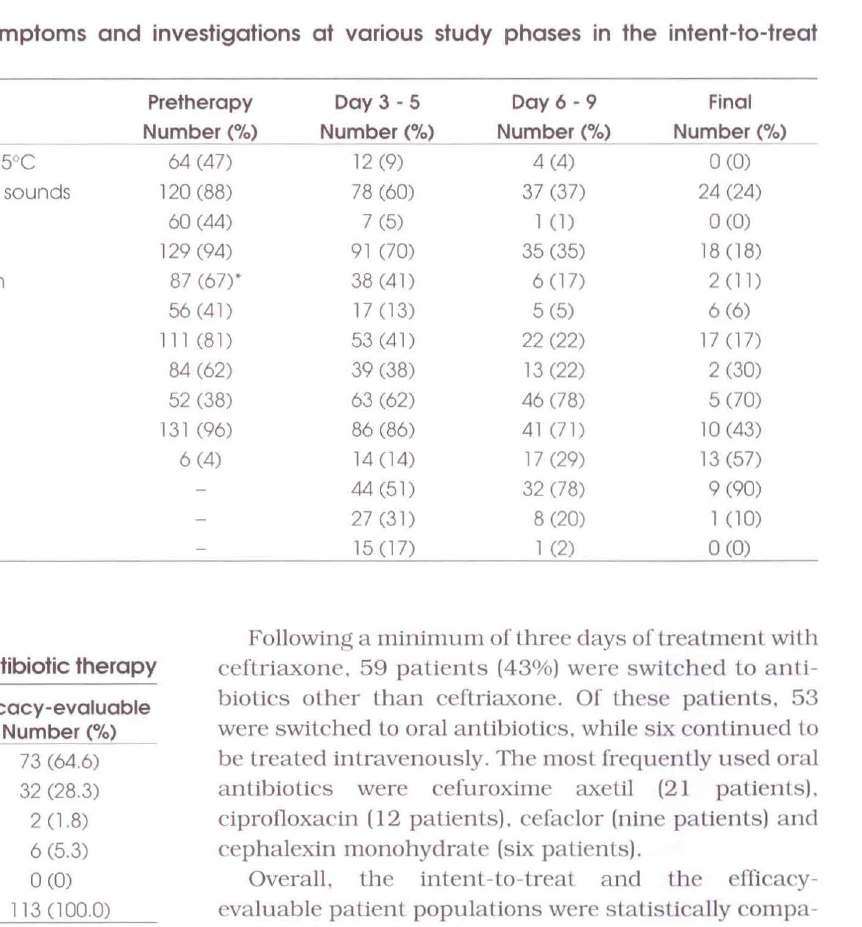
Frequency of abnormalities in signs, symptoms and investigations at various study phases in the intent-to-treat population Pretherapy Day 3 - 5 Day 6 - 9